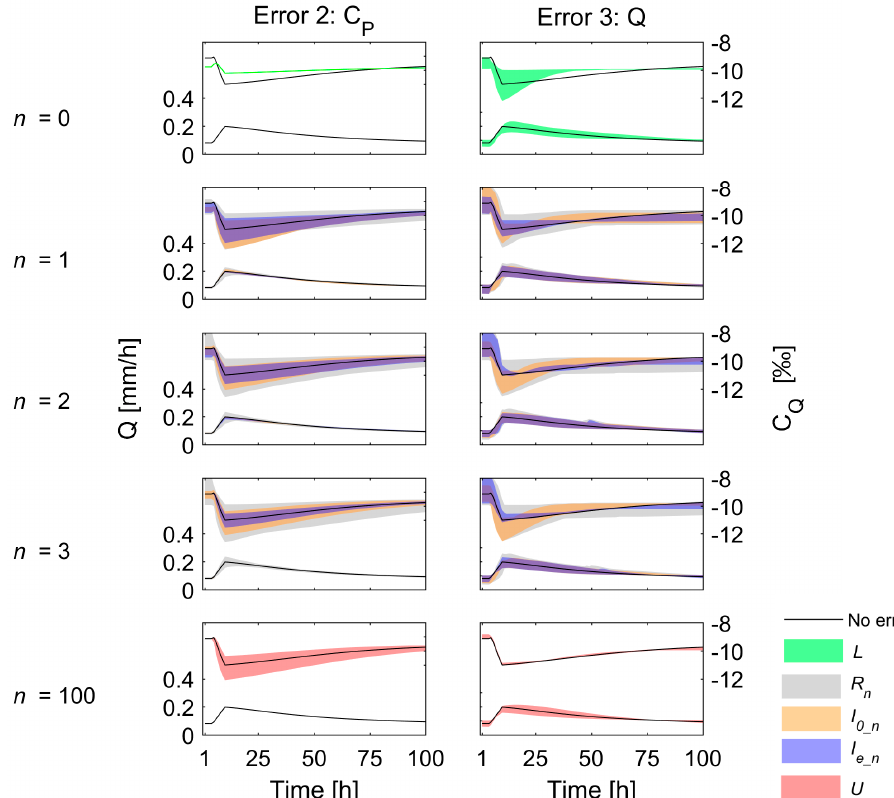
Figure 3. Effect of the different sampling strategies on the simulated range (maximum and minimum value) in streamflow ( Q ) and the isotopic composition of streamflow ( C Q ) for the medium event for parameterization PI. The black lines show the simulations of Q and C Q with no errors (i.e., the data used for validation). Different colors show different sampling strategies (lower benchmark ( L ), random selection ( R n ), two intelligent selections ( I 0_n and I e_n ) and upper benchmark ( U